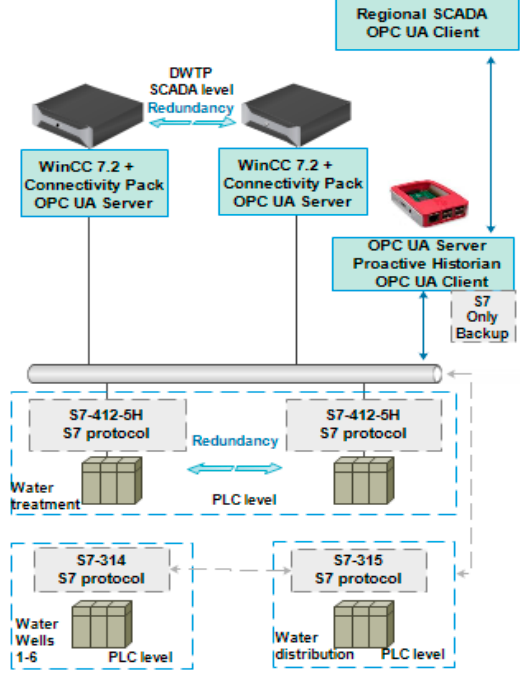
Figure 4. The Historian in relation with the local